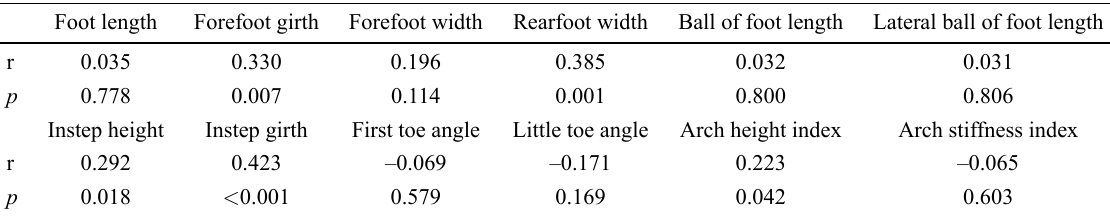
Table 3. Bivariate correlation coefficients (Pearson correlation coefficients) between BMI and parameters of right foot structure in bipedal standing position.